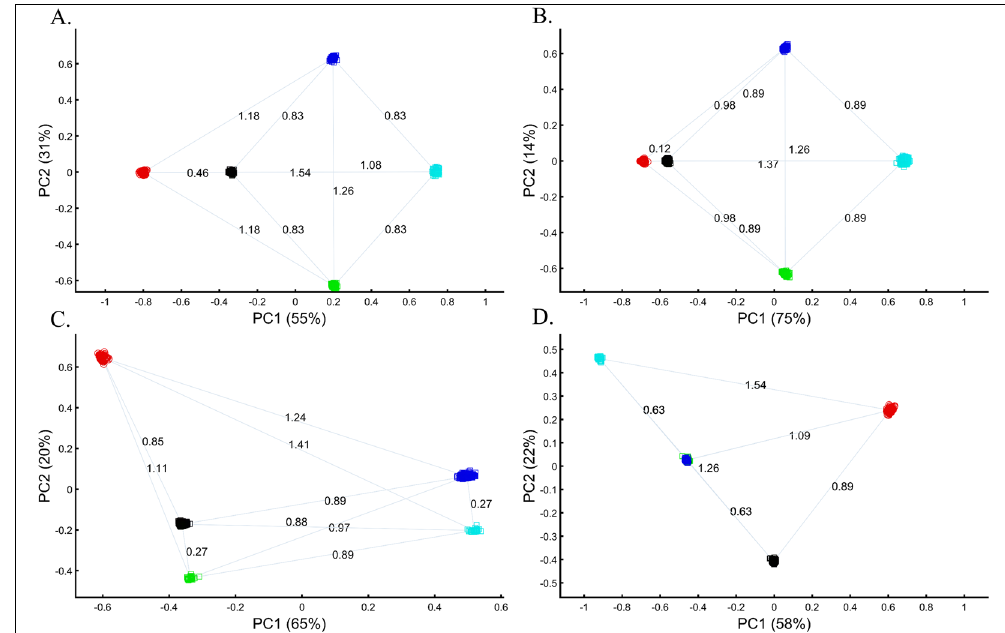
Figure 8. PCA with the primary and mixed color populations. ( A ) n all = 100; n Black = 200, ( B ) n Red = n Green = n Blue = 100; n Black = n Cyan = 500, ( C ) n Red = 100; n Green = n Cyan = 33; n Blue = n Black = 400; and ( D ) n Red = n Black = 100; n Green = n Blue = n Cyan = 33; Scatter plots show the top two PCs. The numbers on the grey bars reflect the Euclidean distances between the color populations over all PCs. Colors include Red [1,0,0], Green [0,1,0], Blue [0,0,1], Cyan [0,1,1], and Black